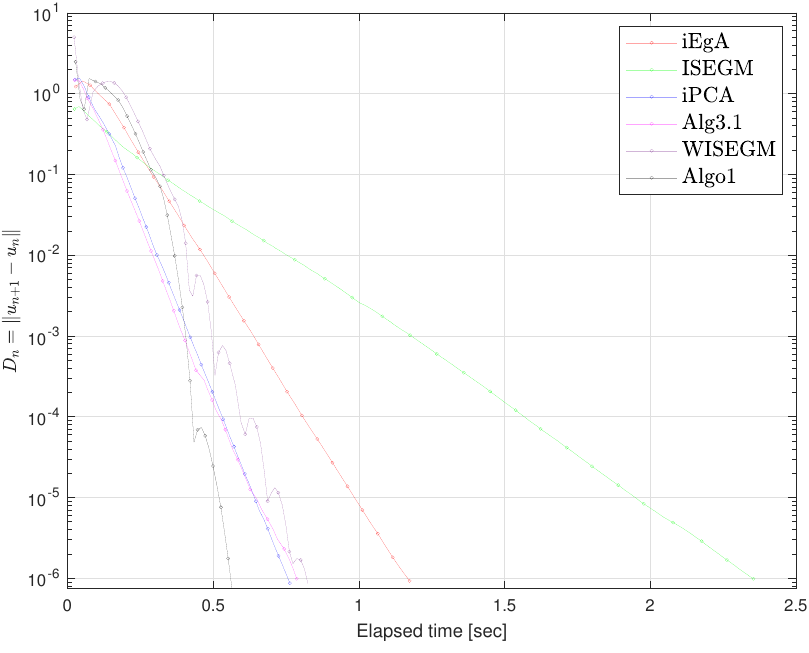
Figure 6. Example 2: Elapsed time are 1.17, 2.35, 0.76, 0.78, 0.82, 0.56